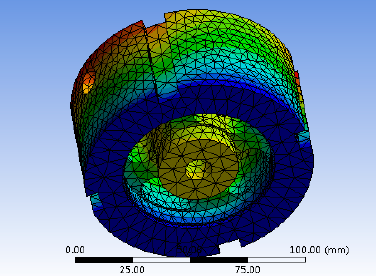
Figure 12. The resonance frequency of the second-order modal.